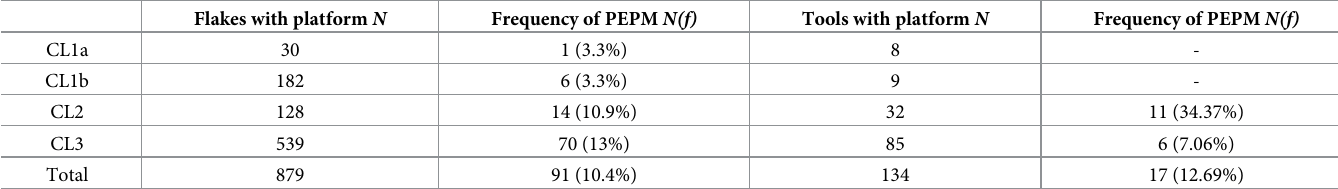
Table 6. The frequency of abrasion and battering on the exterior platform margin. Flakes with platform